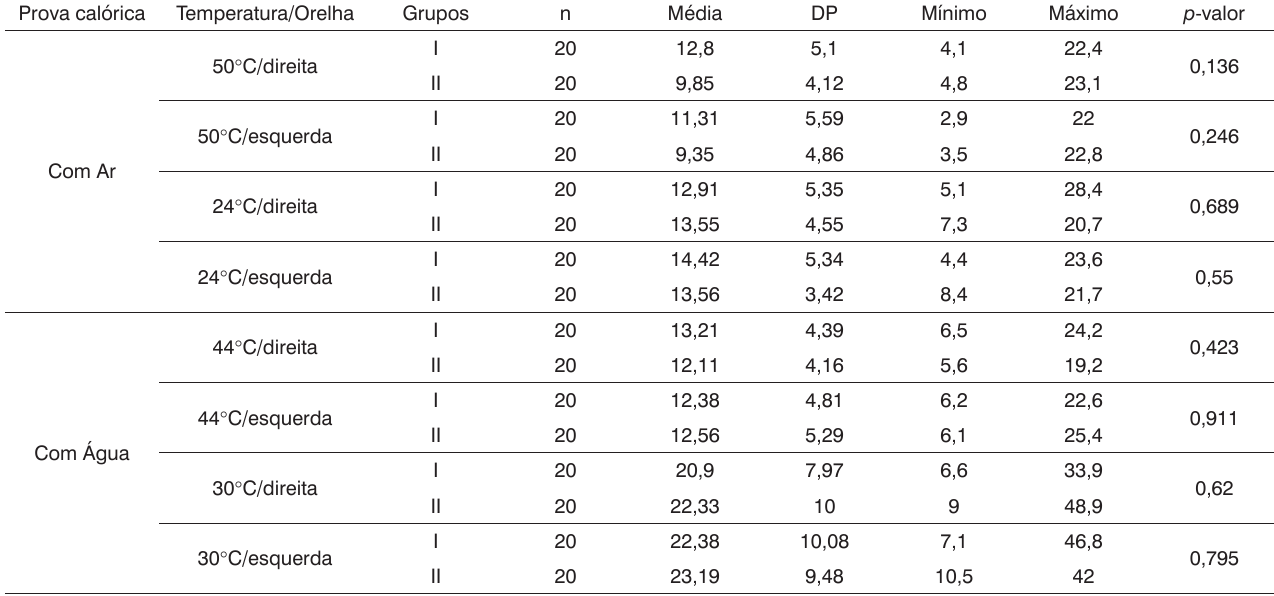
Tabela 2. Valores descritivos do nistagmo pós-calórico à estimulação com ar a 50 ° C e 24 ° C e com água a 44 ° C e 30 ° C e análise comparativa dos resultados entre os grupos.